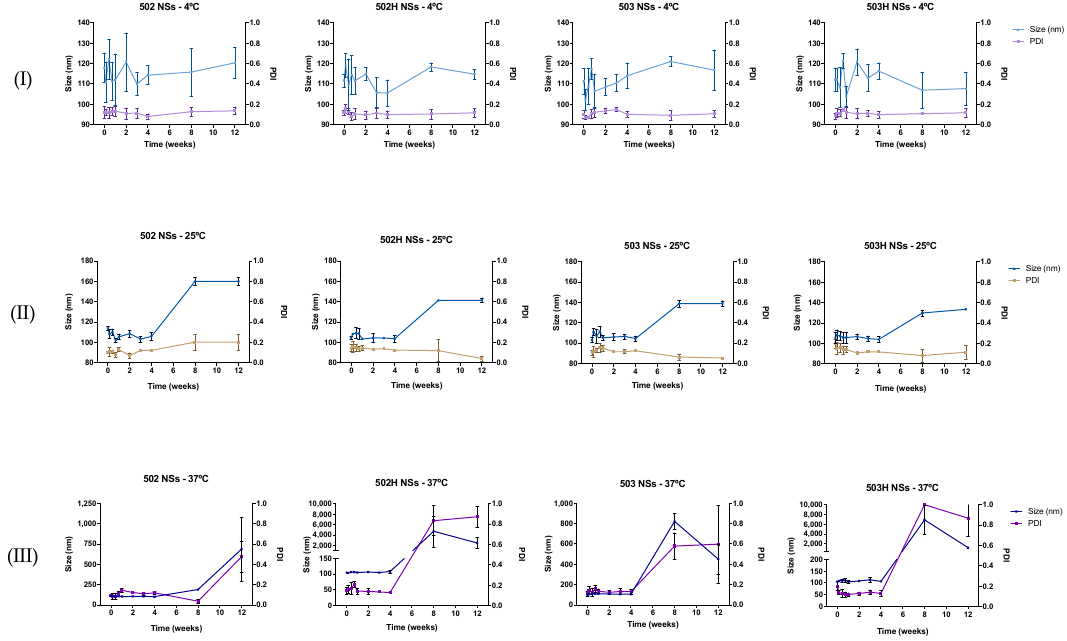
Figure 6. Stability-to-storage study for PLGA-based NSs at three different temperature conditions: ( I ) 4 ± 2 °C, ( II ) 25 ± 2 °C and ( III ) 37 ± 2 °C, respectively.